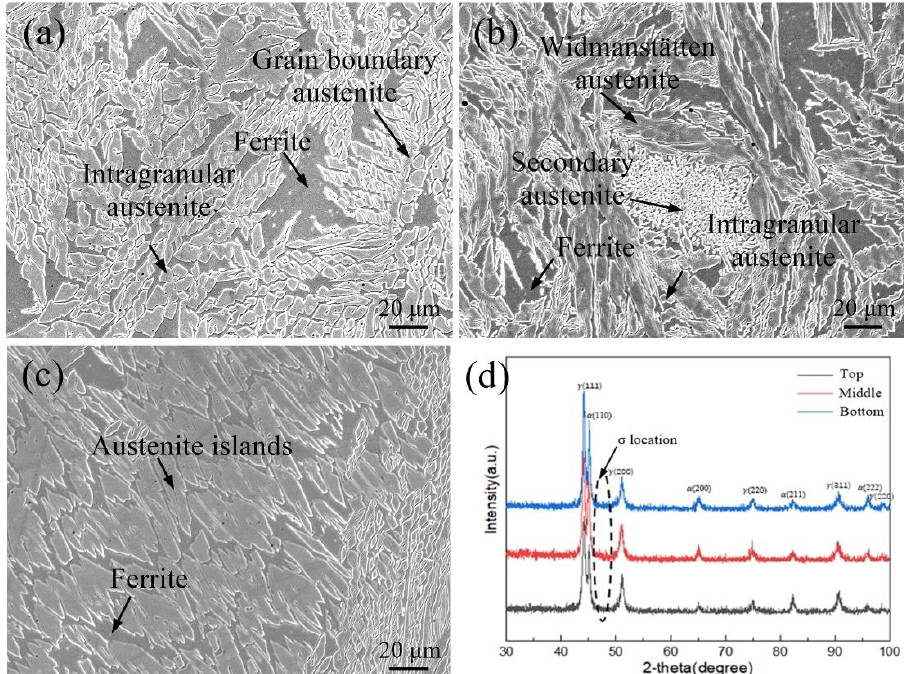
Figure 3. SEM images of multi-layer single-pass additive parts in different areas ( a ) bottom area; ( b ) middle area; ( c ) top area; ( d ) XRD patterns of the bottom, middle and top of the additive parts.